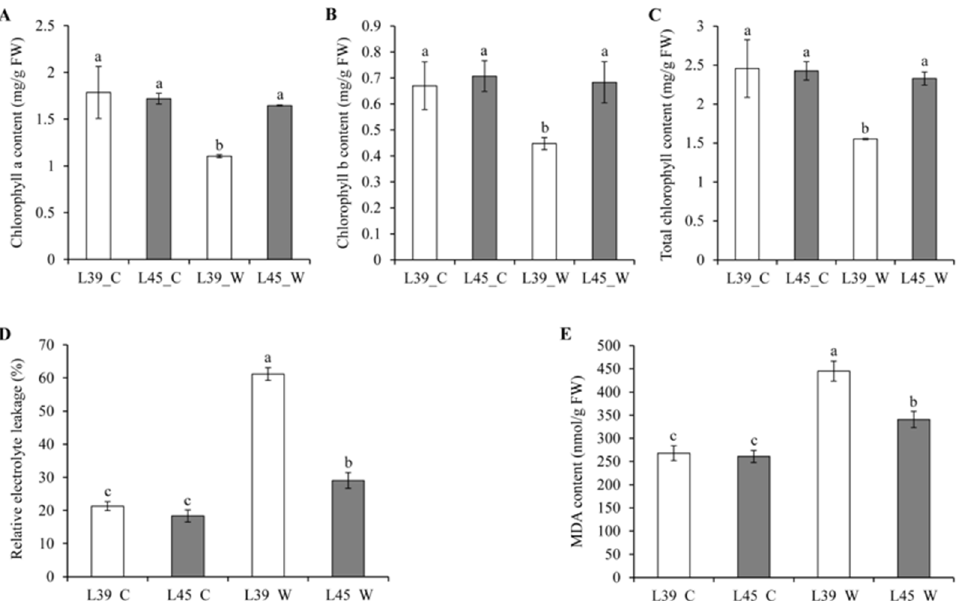
Figure 1. Effects of waterlogging on chlorophyll a content ( A ), chlorophyll b content ( B ), total chlorophyll content ( C ), relative electrolyte leakage ( D ), and malondialdehyde (MDA) content ( E ) in ‘L39’ and ‘L45’. Data are presented as means ± standard deviation. Significant differences at p < 0.01 with an LSD test are indicated by different letters.